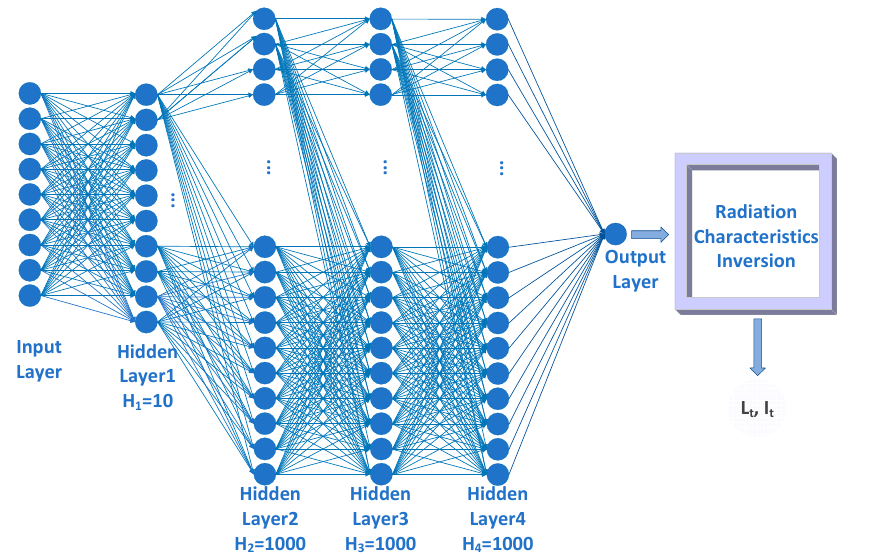
Figure 8. The architecture of the radiation characteristic measurement model based on the DNN.